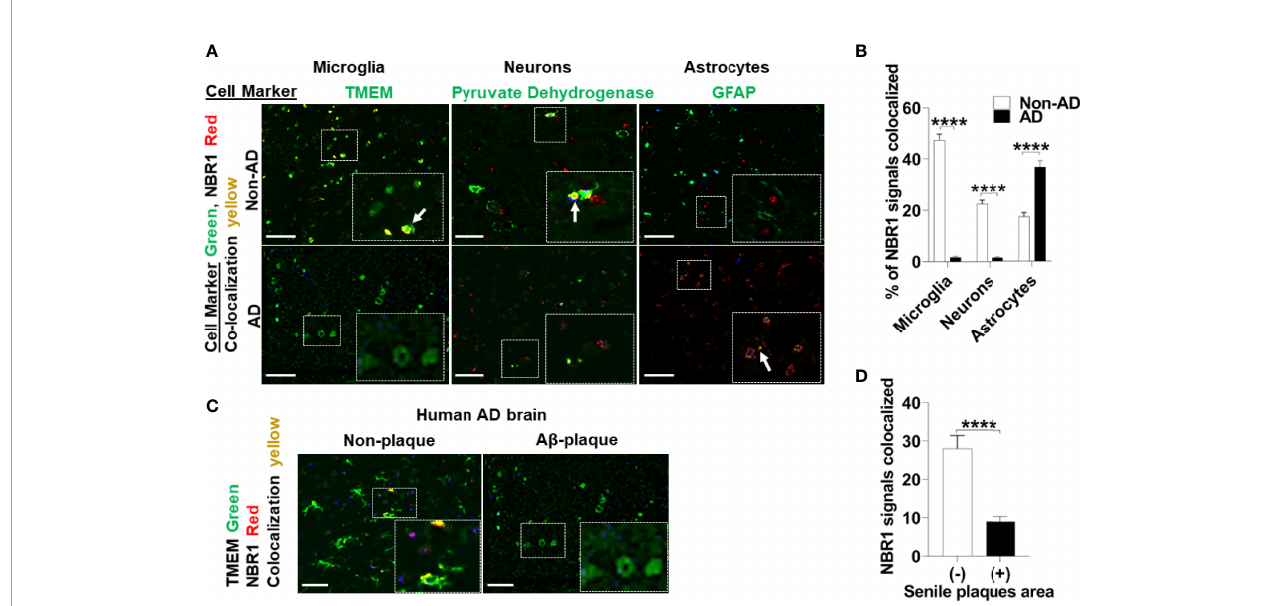
FIGURE 3 | NBR1 is downregulated in microglia of human Alzheimer ’ s disease mainly in regions with high A b burden. (A) Co-expression images of Immunohistochemistry of NBR1 (red) expression and cell marker (green) (TMEM for microglia, pyruvate dehydrogenase for neurons and GFAP for astrocytes) in human AD brain tissue sections and age matched no disease control. Colocalization is represented in yellow as indicated by arrows. Scale bar: 100µM. (B) Quanti fi cation of images represented in (A) were performed by Nuance system (CRI) (n = 3) (5 randomly chosen 20x fi elds of view per biologic replicate were analyzed). Statistical analysis was performed using multiple unpaired two-tailed student ’ s t-test. (C) Representative images of the co-expression analysis of Immunohistochemistry of NBR1 (red) expression and TMEM+ microglia (green) in A b deposits negative (-) and positive (+) regions of AD brain tissue sections (n = 3). Scale bar: 100µM. (D) Quanti fi cation of images represented in (C) were performed as described in (B) . Statistical analysis was performed using unpaired two-tailed student ’ s t-test. ****p ≤